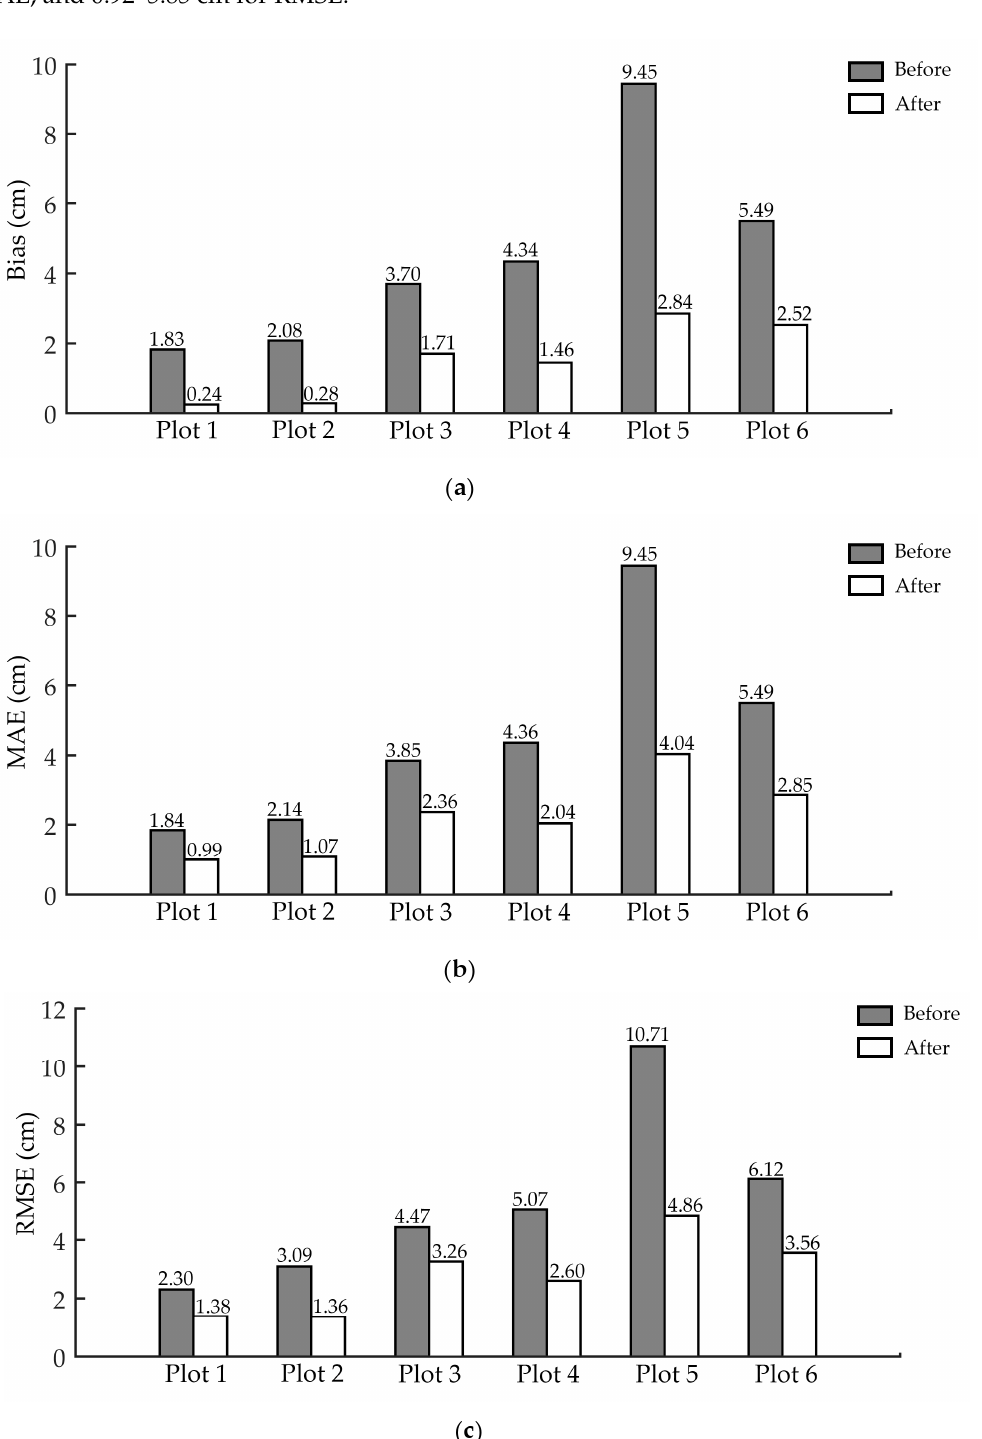
Figure 10. DBH (diameter of breast height) estimation errors for different plots before and after applying ANPDA based on ( a ) bias, ( b ) mean absolute error (MAE), and ( c ) root mean squared error (RMSE). The black bars show the DBH estimation error before applying ANPDA, while the red bars show the error after applying ANPDA.